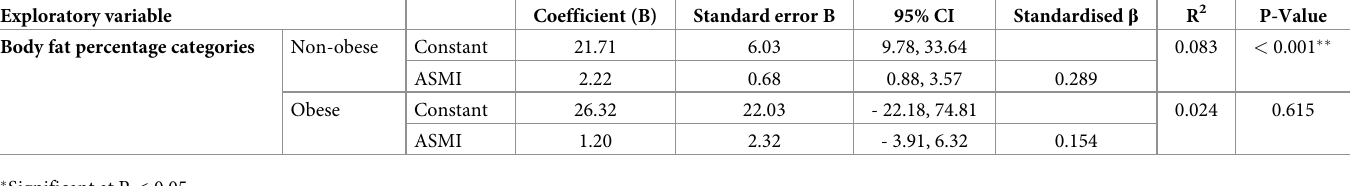
Table 5. Results of multiple linear regression modelling on the effect of obesity in the relationship between muscle strength and mass in older males. Exploratory